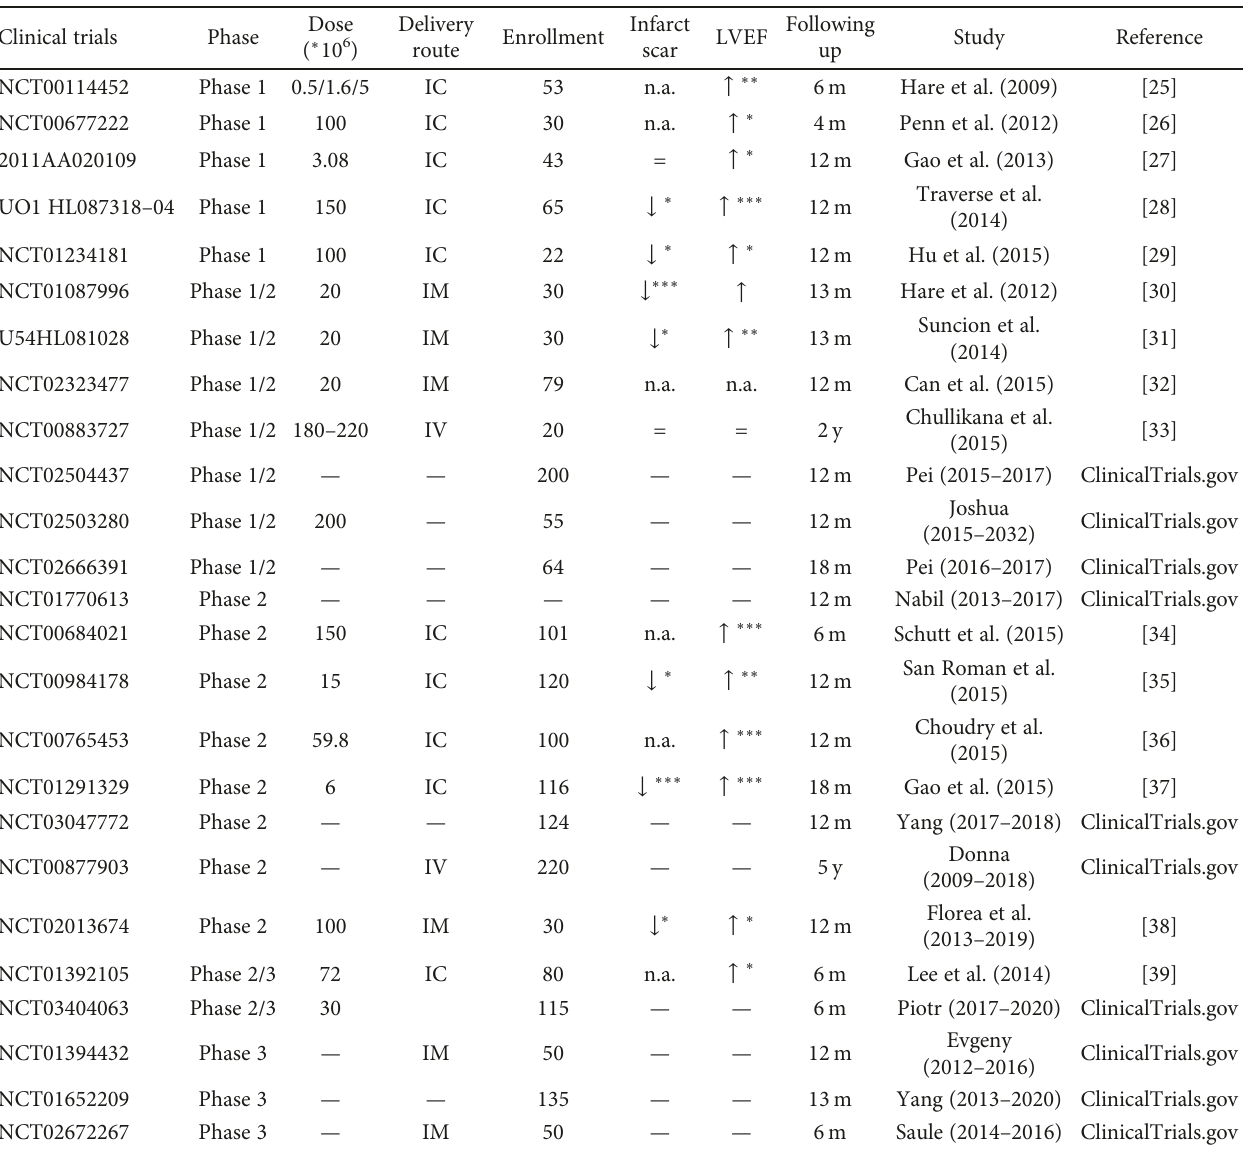
Table 1: Clinical trials of MSC transplantation for treating